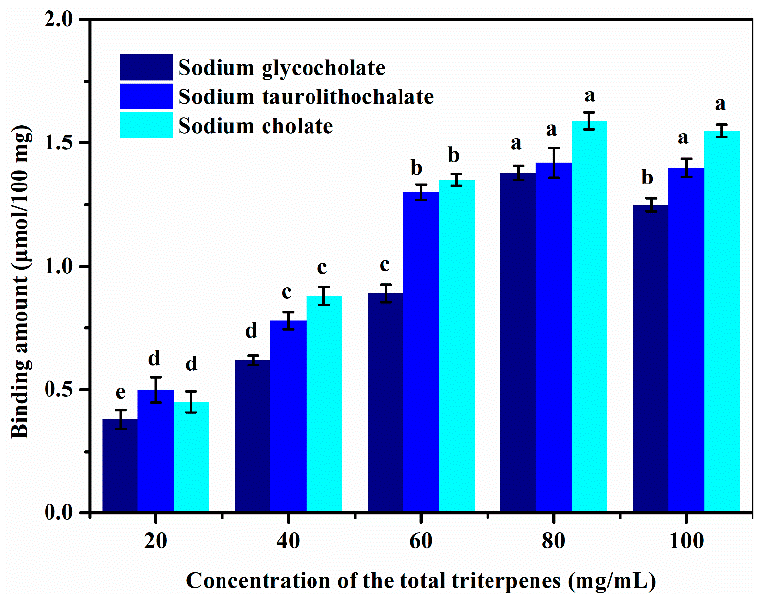
Figure 2. The amount of total triterpenoids bound to cholic acid salt in the sclerotia of PTRSS. Note: There are no significant differences between means with identical letters in a column ( p < 0.05). Table 1. The capacities of total triterpenoids from the sclerotia of PTRSS for binding with bile salts in